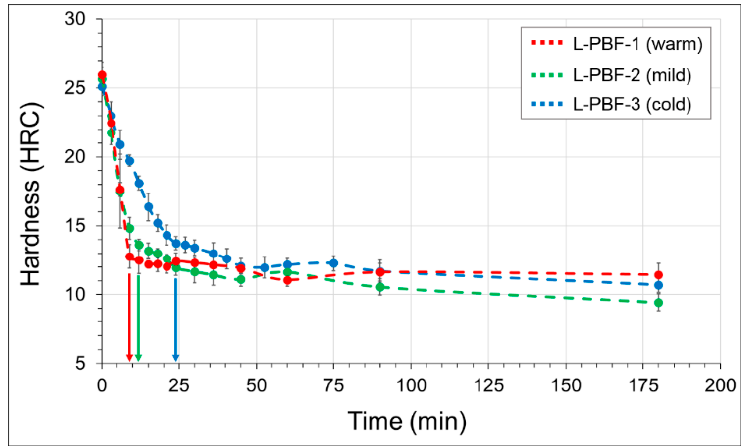
Figure 14. Hardness versus holding time during heat treatment at 1100 °C for L-PBF-1, 2, and 3 conditions. Threshold times t rec corresponding to complete sample recrystallization are indicated with arrows. Shorter recrystallization times (~9 min) were obtained for the warmer L-PBF condition (L-PBF-1).